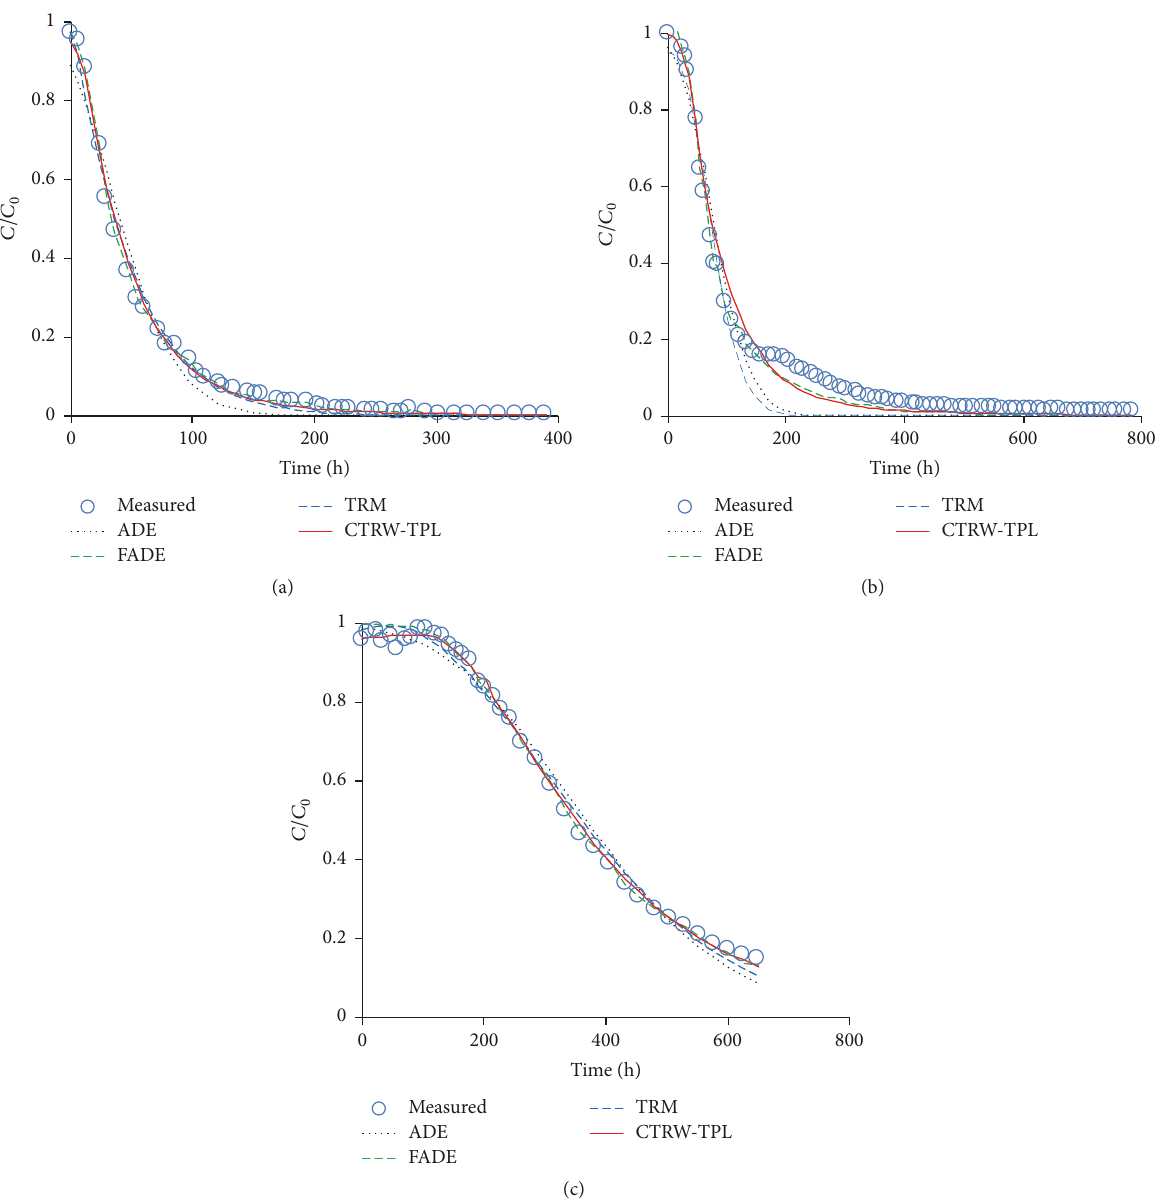
Figure 6: Three sets of measured leaching curves fitted with ADE, FADE, TRM, and CTRW (based on TPL), for the homogeneous, saturated, and smooth wall soil columns with the same inner diameter (14cm) but different column lengths: (a) 3 cm; (b) 5 cm; (c) 8